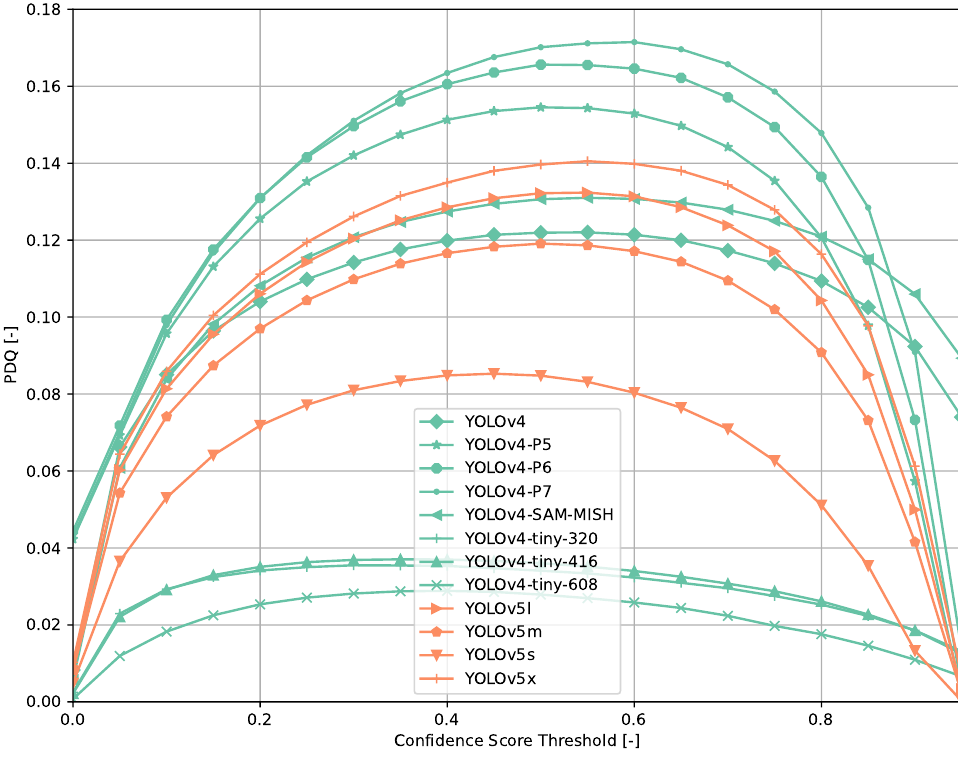
Figure 14. PDQ results of YOLOv{4, 5} on the COCO